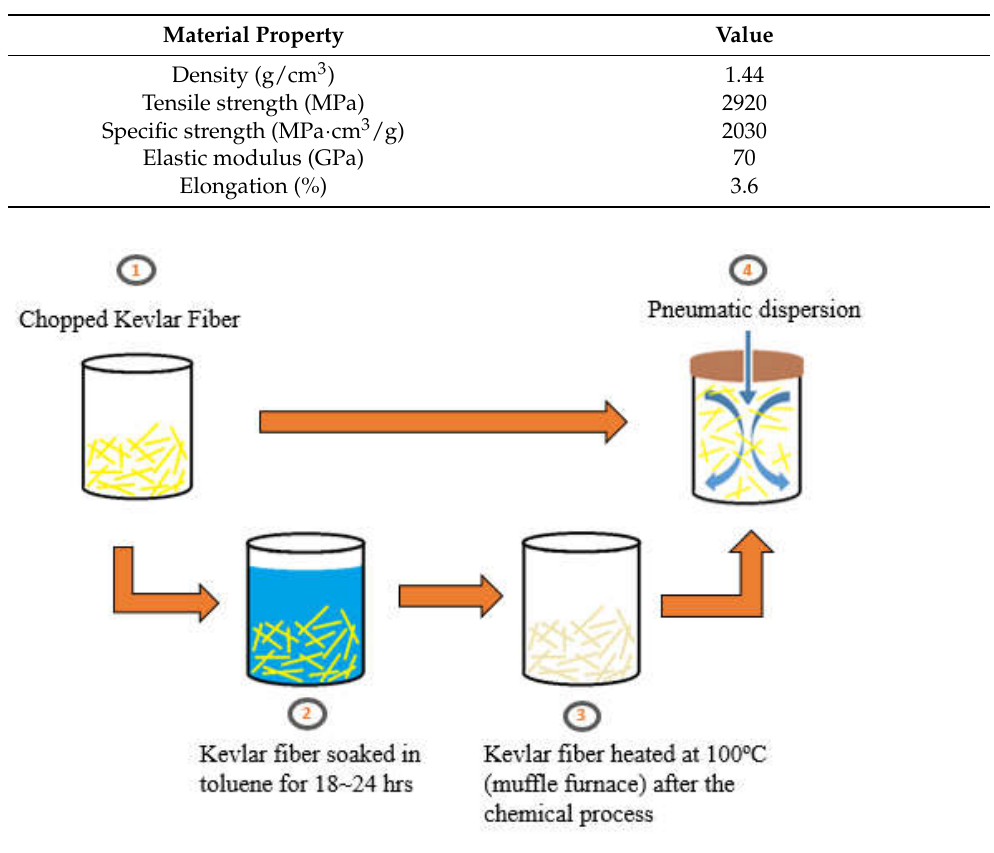
Figure 1. The original KF and sizing-removed KF pretreatment methods. Table 2. Material properties of Kevlar ® 29 fiber